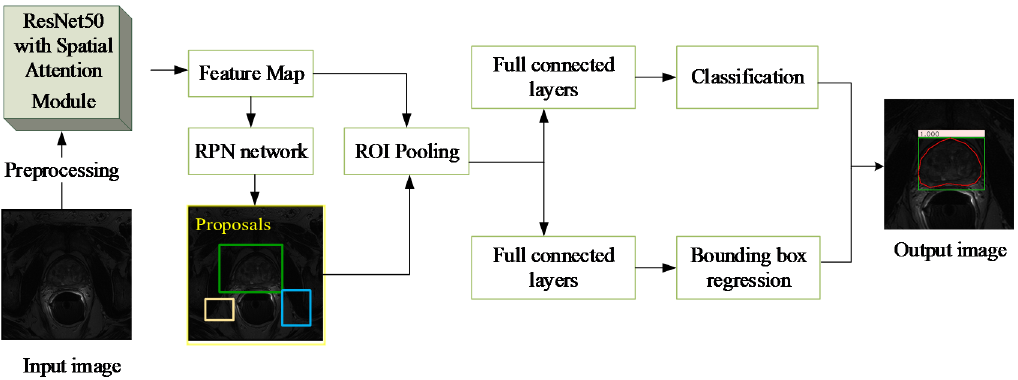
Figure 4. The flowchart of RA-FasterRCNN.